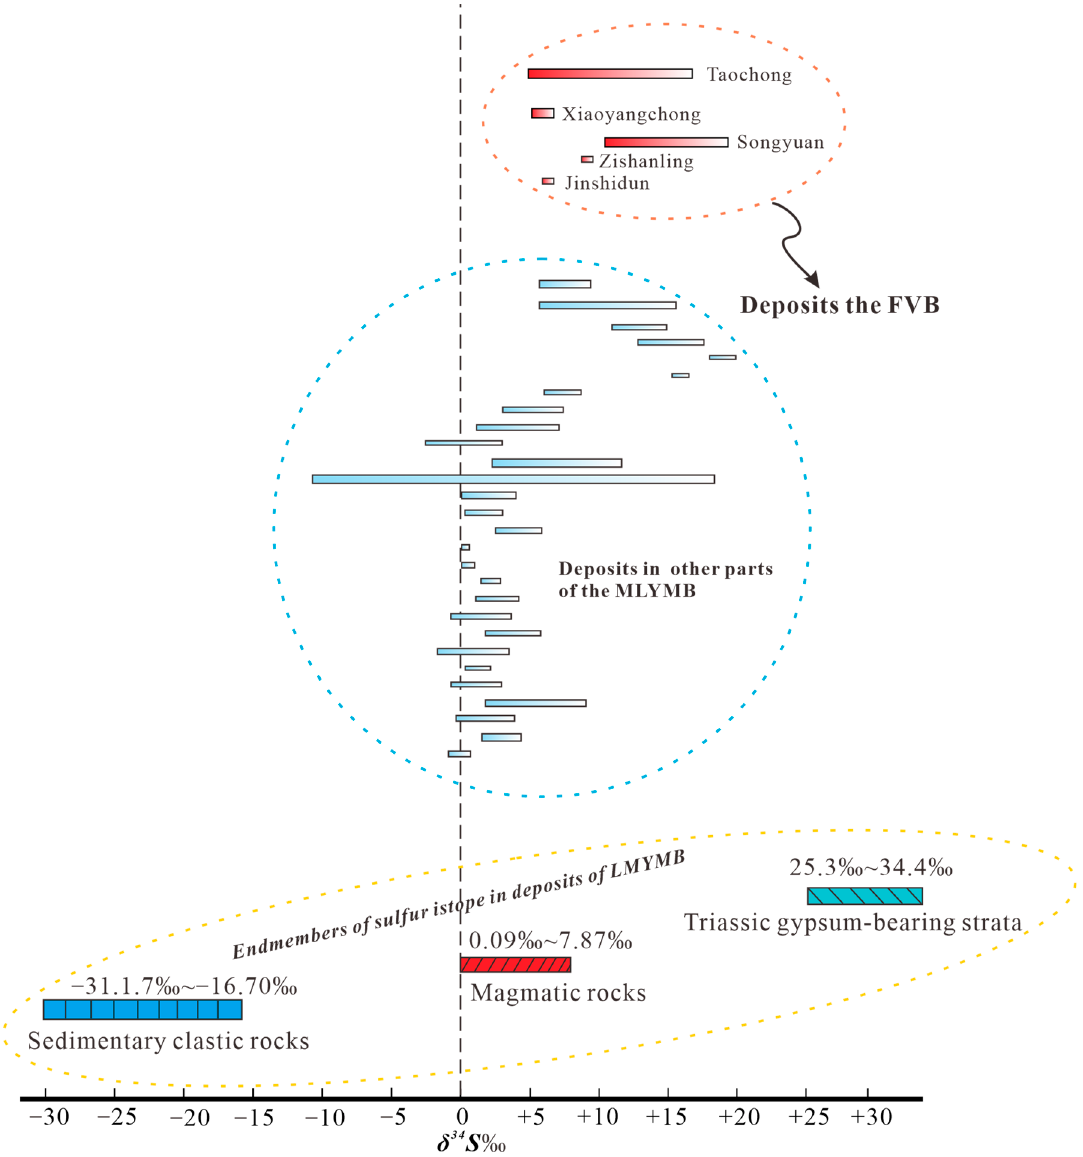
Figure 15. δ 34 S ranges of metal sulfides from some typical skarn deposits in the FVB (see Supplement Table S7) and other Yanshanian deposits with endmembers of sulfur isotopes in the MLYMB (after [117]).